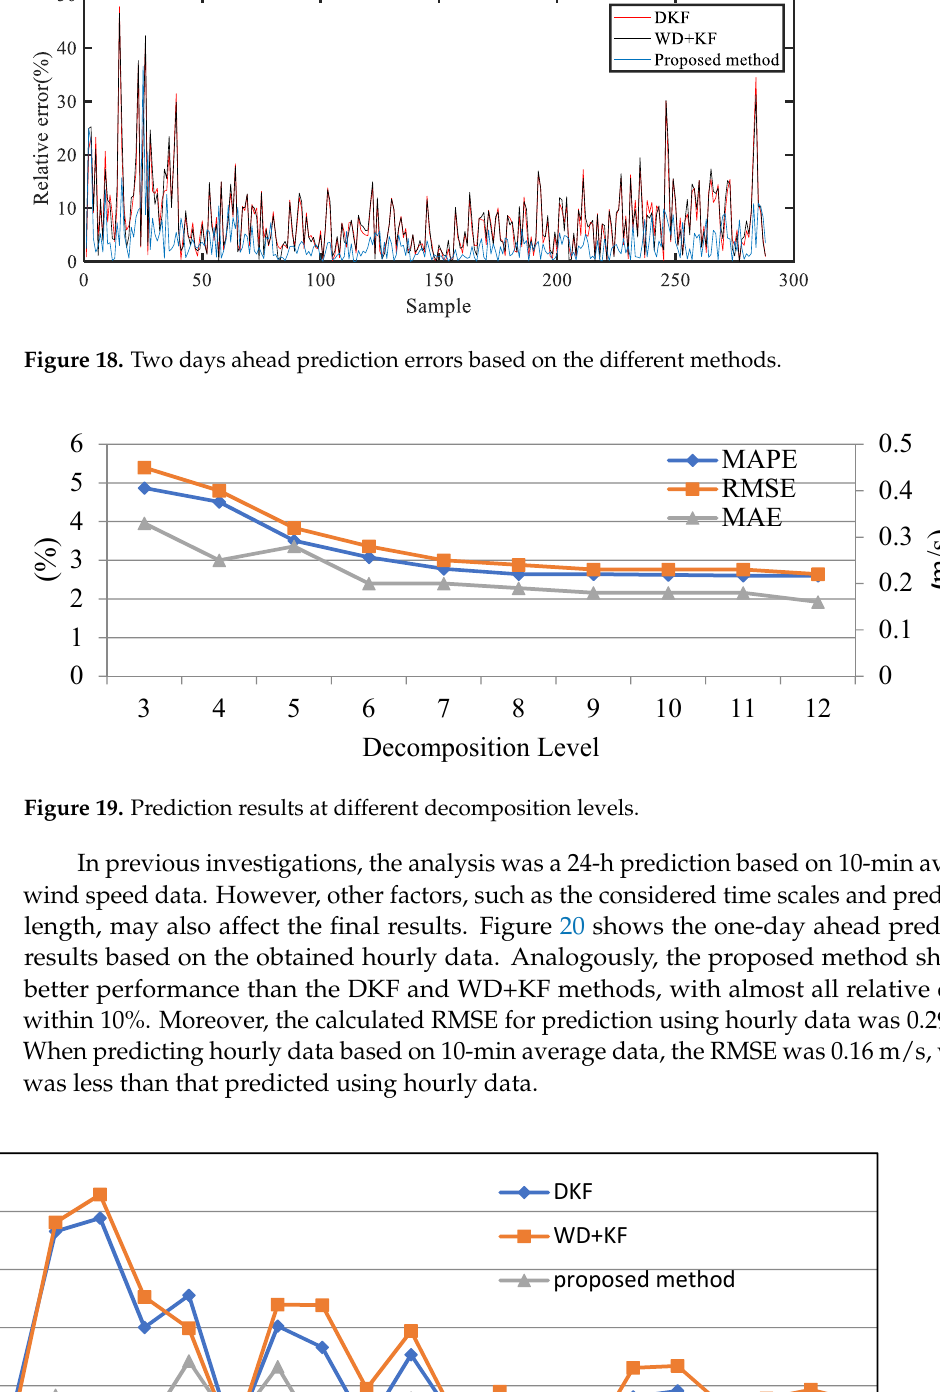
Figure 18. Two days ahead prediction errors based on the different methods.